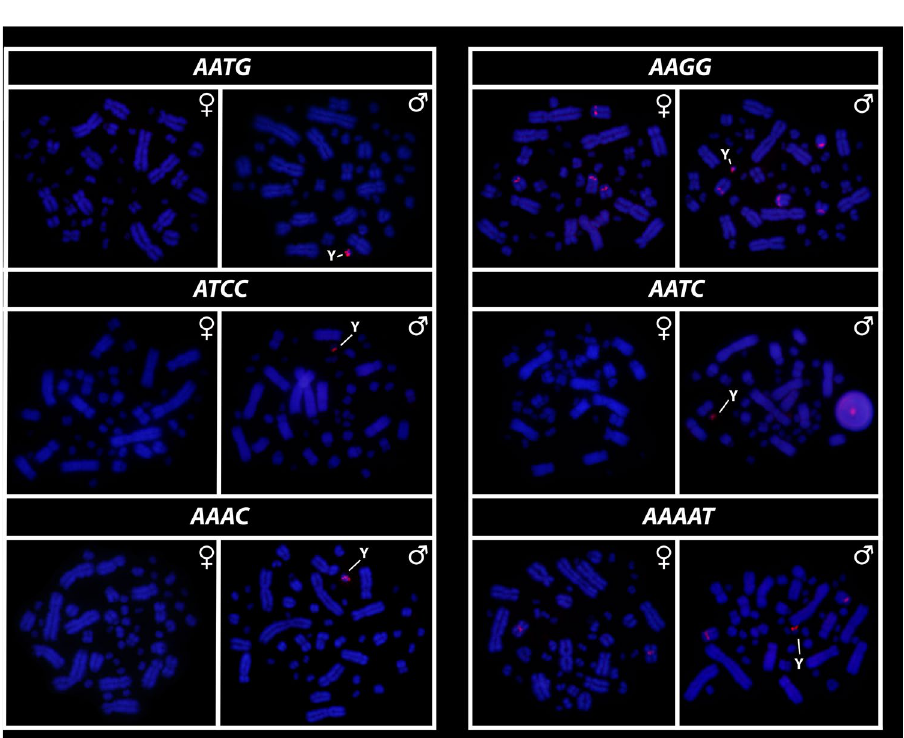
Figure 4. Mapping of SSRs on the chromosomes of males and females of Chelus fimbriata , with highlights to the particular accumulation on the mic Y